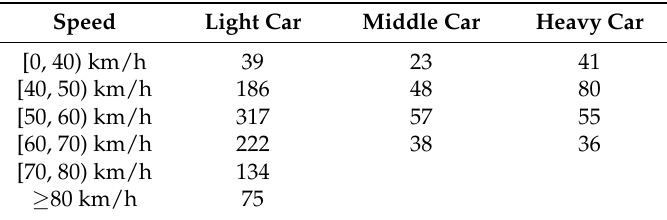
Table 1. Distribution of the samples of vehicle noise spectra.